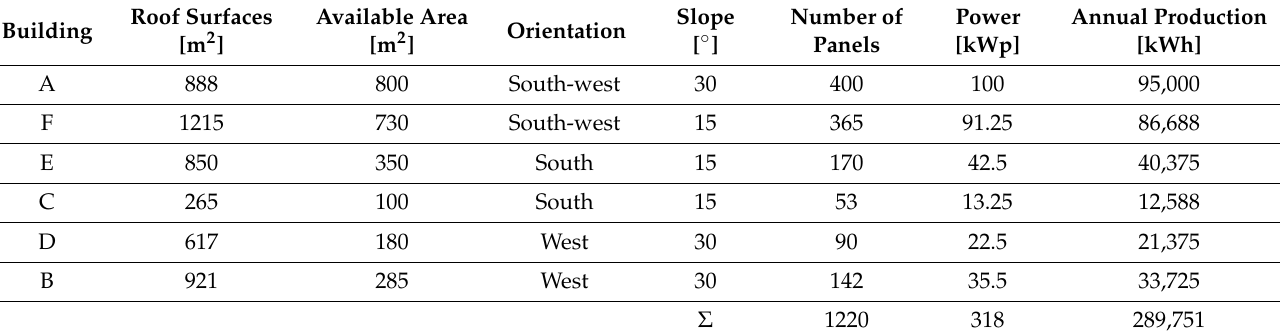
Table 3. Photovoltaic Panel Number Design.